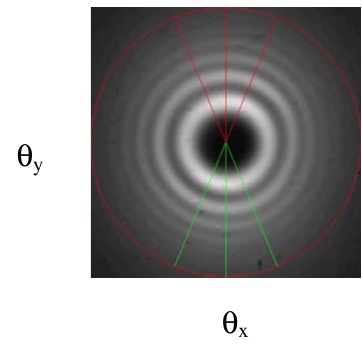
FIG. 9. (Color) OTR interferences for the 95 MeV NPS at a y (vertical) waist; overlay: sectors over which the intensity at each radius is